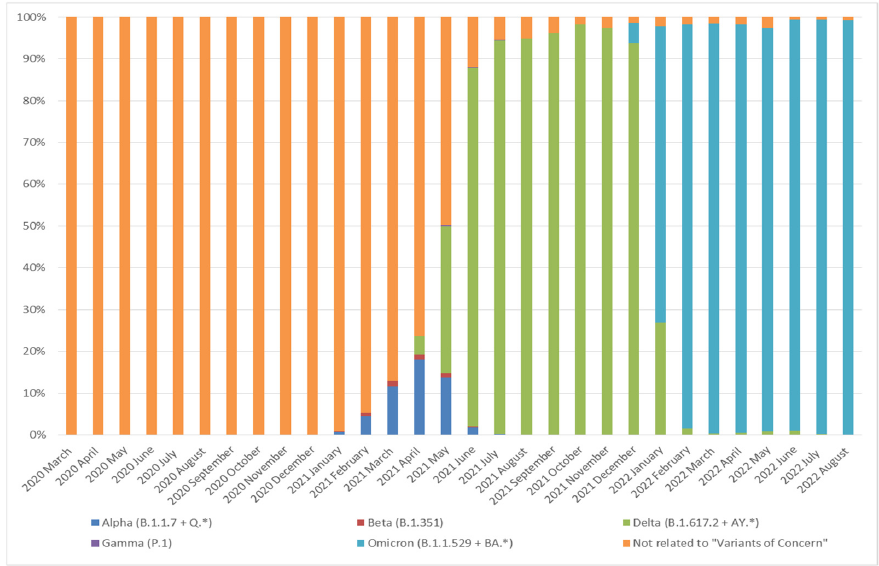
Figure 2. Dynamics of variant structures of SARS-CoV-2 in Russia by month from March 2020 to August 2022 by whole-genome sequencing (* include all sublineages) [21].